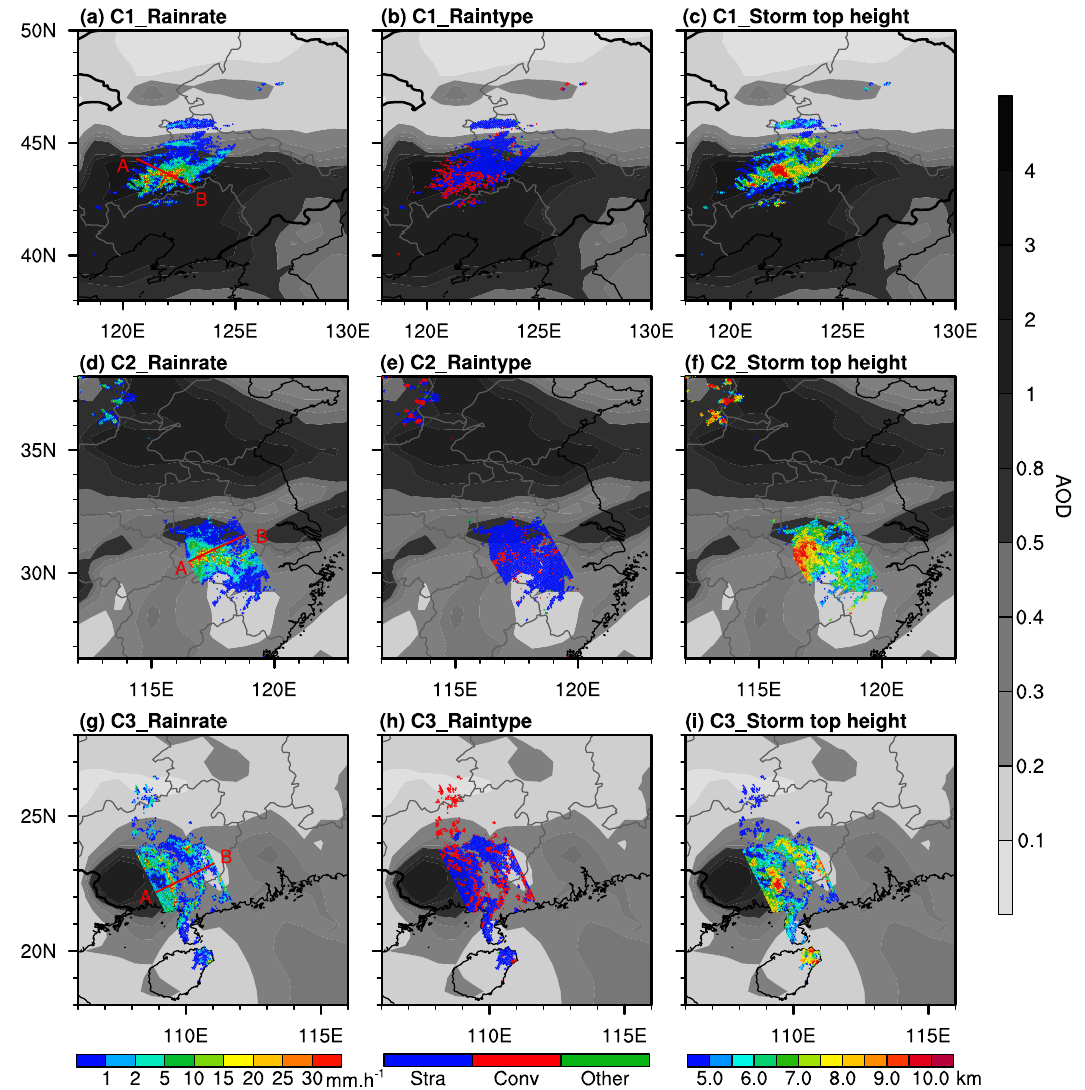
Fig. 2 Aerosol horizontal distribution cases. a Distribution of AOD and rain rate in C1. b Distribution of AOD and rain type in C1. c Distribution of AOD and storm top height in C1. d Distribution of AOD and rain rate in C2. e Distribution of AOD and rain type in C2. f Distribution of AOD and storm top height in C2. g Distribution of AOD and rain rate in C3. h Distribution of AOD and rain type in C3. i Distribution of AOD and storm top height in